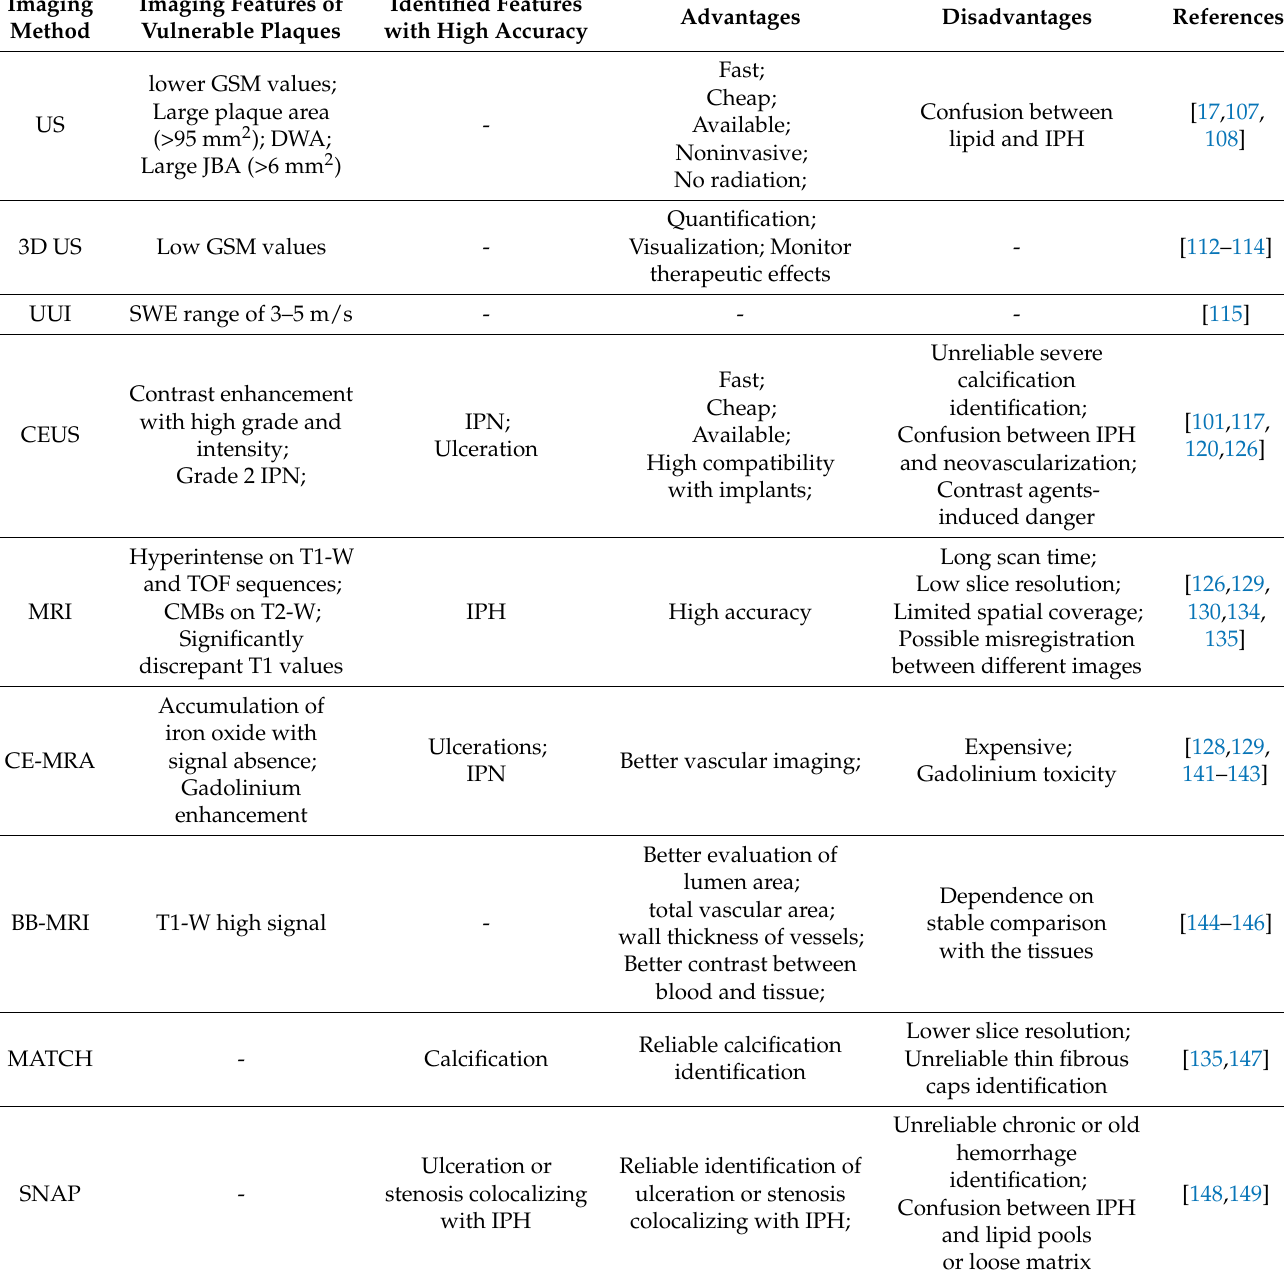
Table 2. Identification of vulnerable plaques via imaging